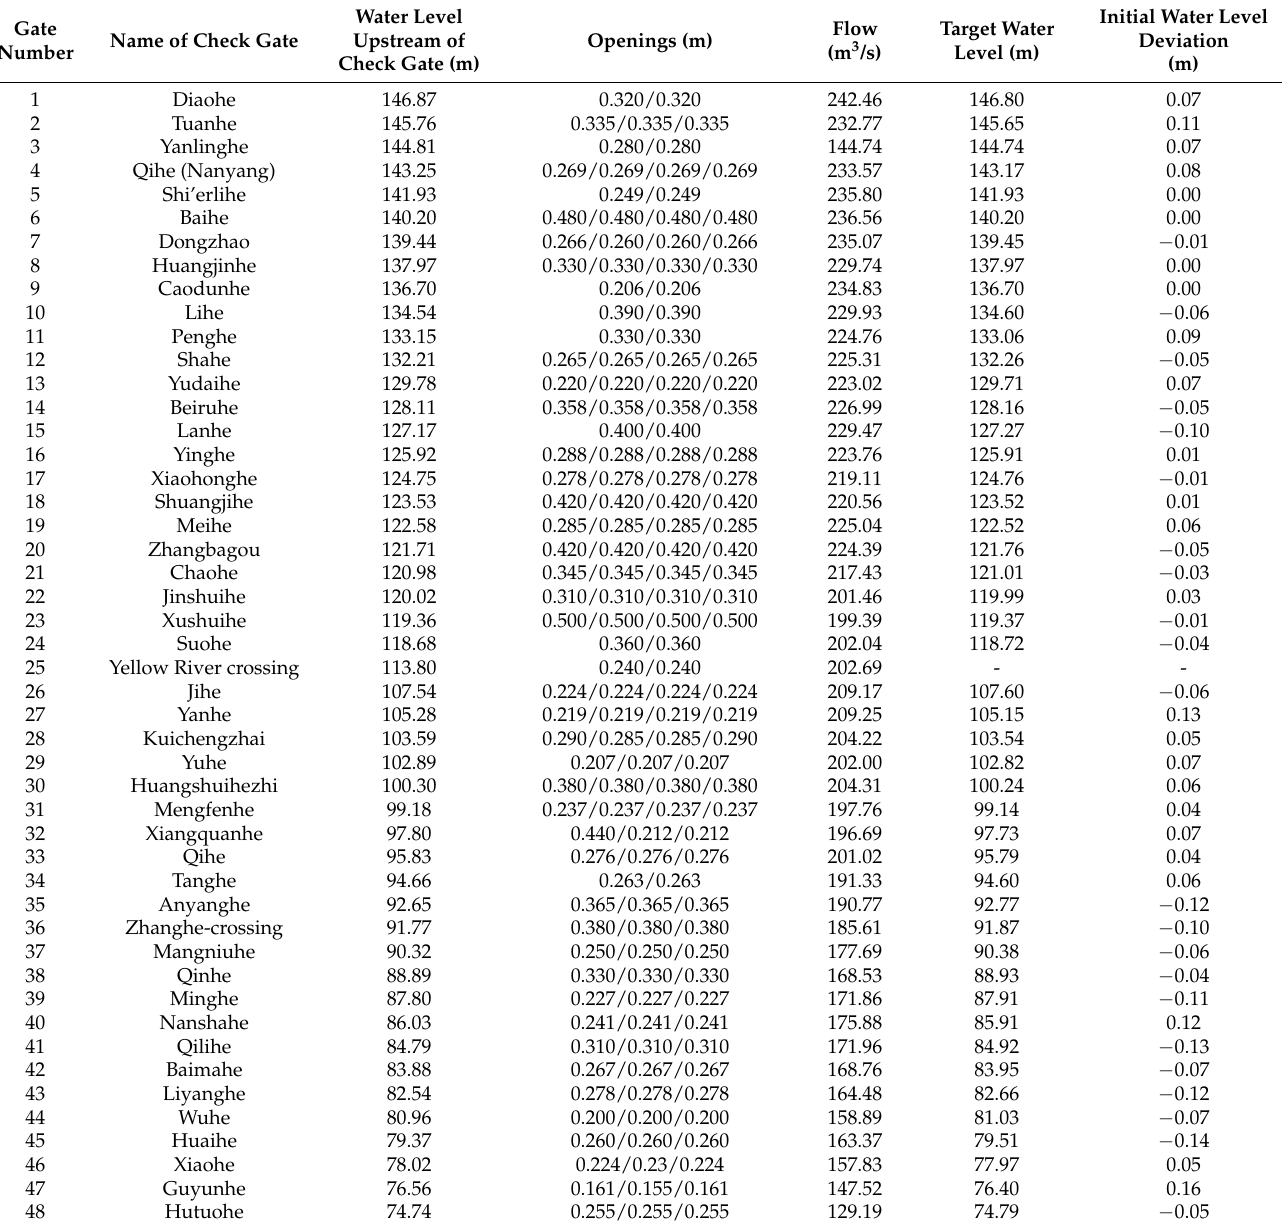
Table 2. The initial state and target water level of canal